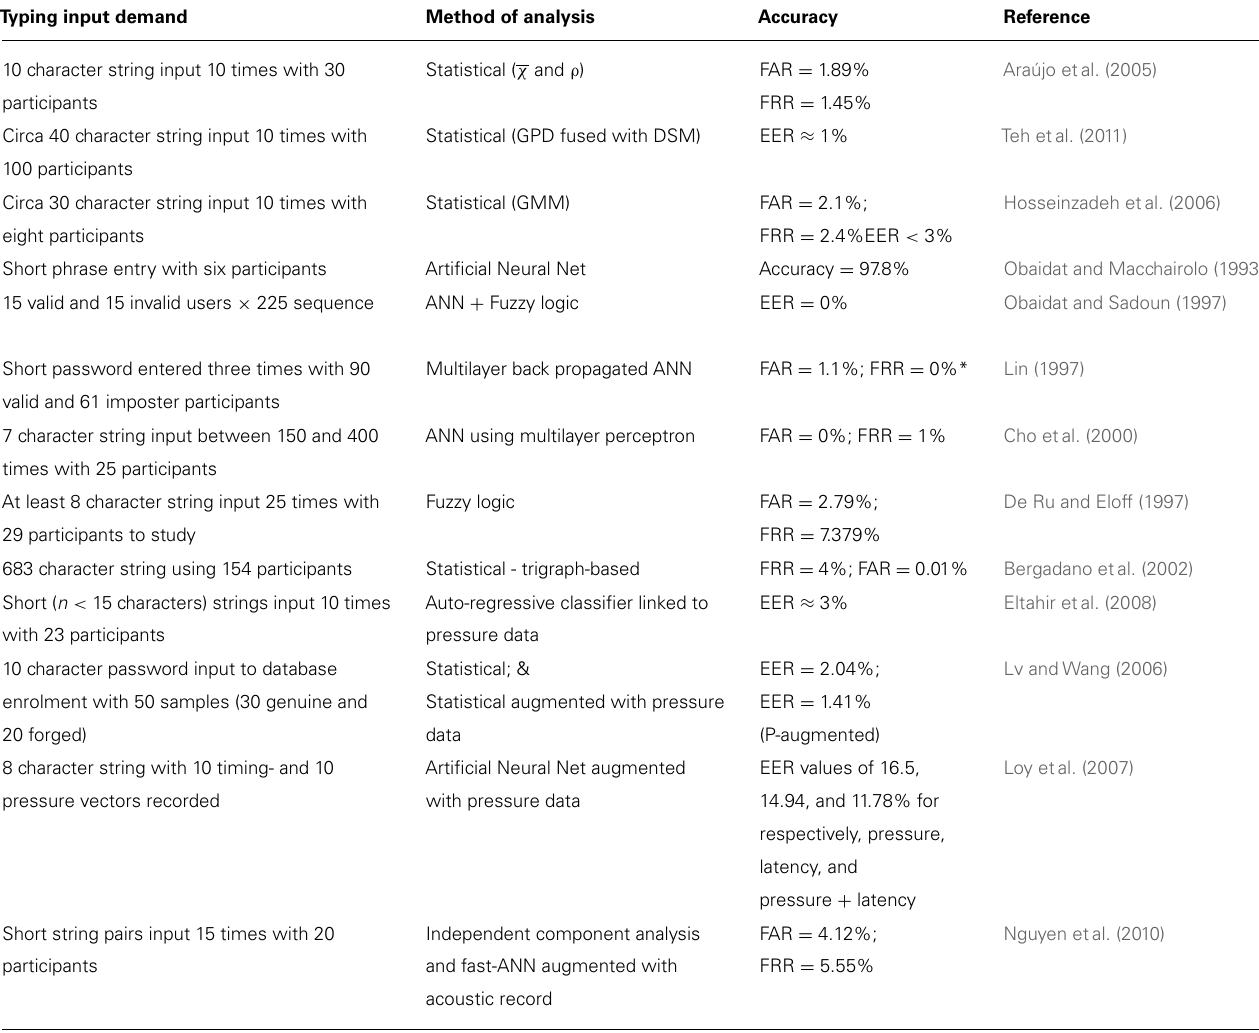
Table 1 | Summary of salient typing demand, analysis mode, and accuracy rates for a spectrum of different keystroke biometric